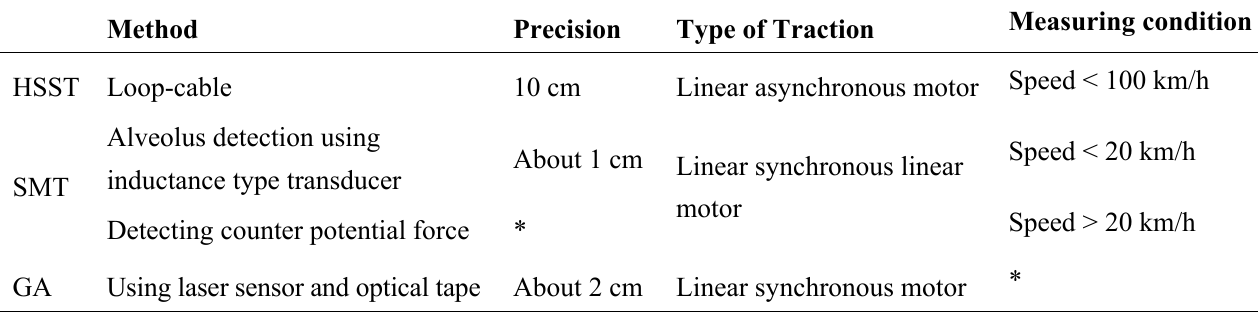
Table 1. Comparisons of the different measurement methods used in HSST, SMT and GA.